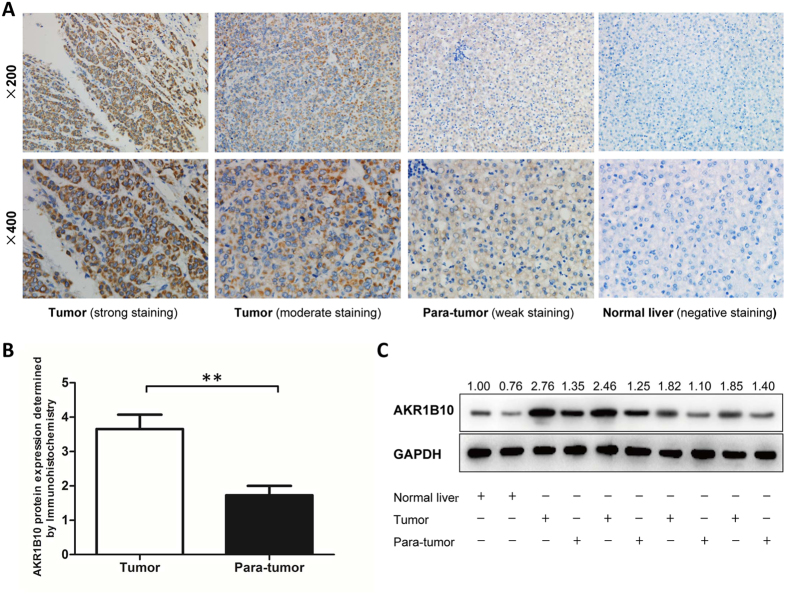
Up-regulated expression of AKR1B10 protein in hepatitis B virus (HBV)-related hepatocellular carcinoma (HCC) tissues.(A) Representative images of immunohistochemistry staining of AKR1B10 in HBV-related HCC, adjacent non-tumor, and normal liver tissues. (B) Mean AKR1B10 protein level detected by immunohistochemistry was significantly higher in HBV-related HCC tissues than in adjacent non-tumor tissues. **P < 0.01. (C) AKR1B10 protein expression detected by Western blotting assay in 4 pairs of HBV-related HCC and adjacent non-tumor tissues as well as in 2 cases of normal liver tissue. (full-length blots are presented in Supplementary Figure 1 A and B; 1 A, AKR1B10; 1B, GAPDH).